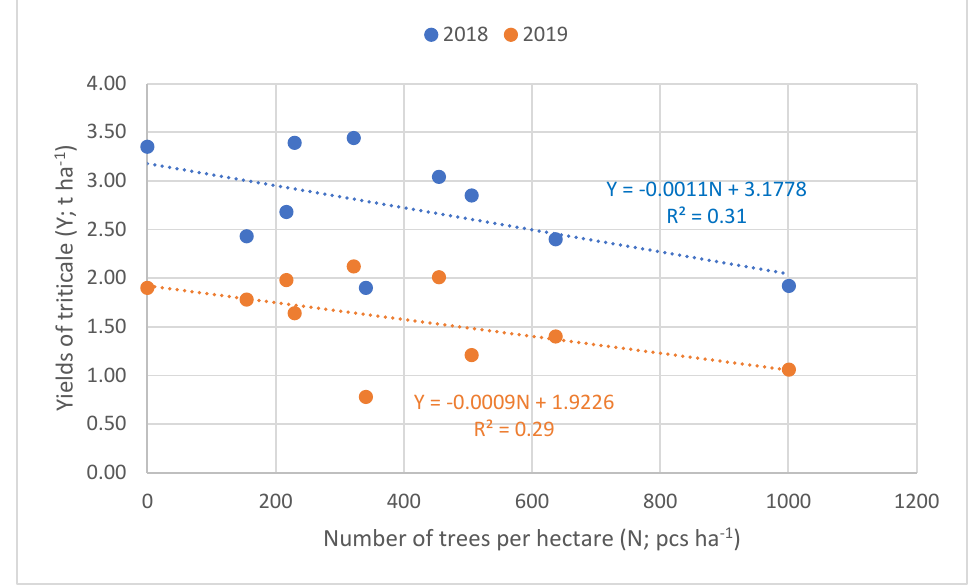
Figure 4. Relationship between the yields of the intercrop in alley cropping systems with different number of trees per hectare ( α = 0.05, n = 9).